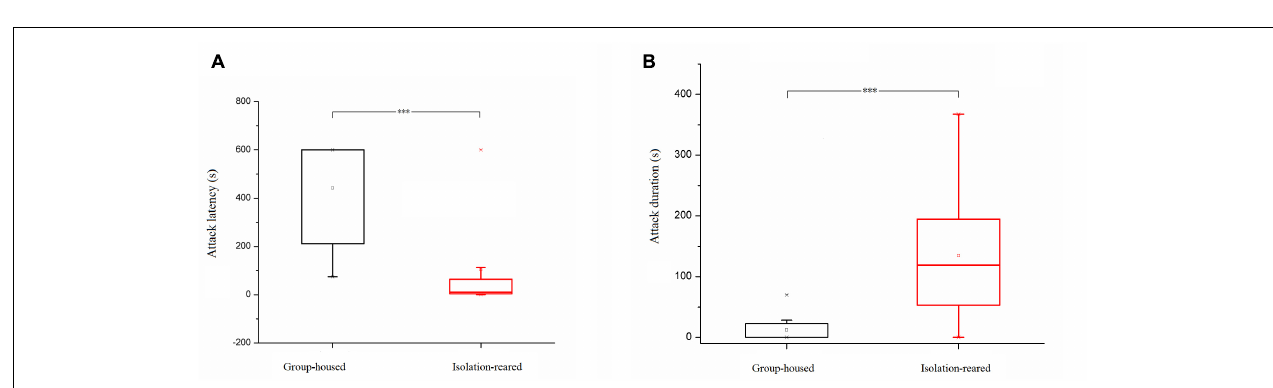
FIGURE 3 | The exploration time of isolation-reared and group-housed mice in the social memory tests. ∗ Indicate p < 0.05. Bar represent mean. Error bar represent SD.